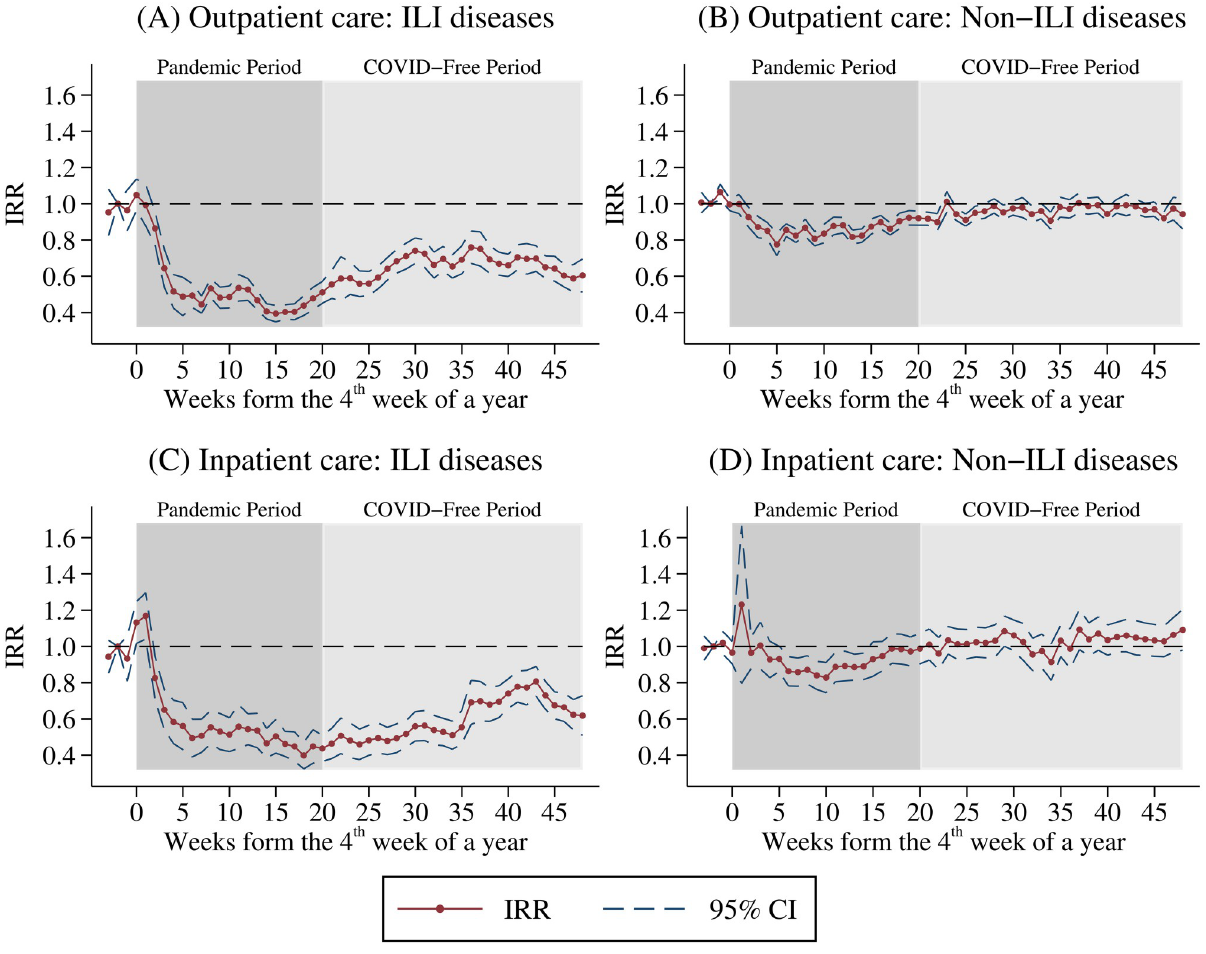
Fig 3. Dynamic effects of the COVID-19 outbreak on non-COVID-19 health utilization. A: Outpatient care: ILI diseases. B: Outpatient care: Non- ILI diseases. C: Inpatient care: ILI diseases. D: Inpatient care: Non-ILI diseases. This figure shows the IRR of the estimated β represent the corresponding 95% confidence intervals. The horizontal axis denotes the number of weeks from the COVID-19 outbreak (i.e., the 4 th week in a year). The top (bottom) panel displays the results for outpatient (inpatient) care by disease type. Sample size is 8,008, and the sample period is